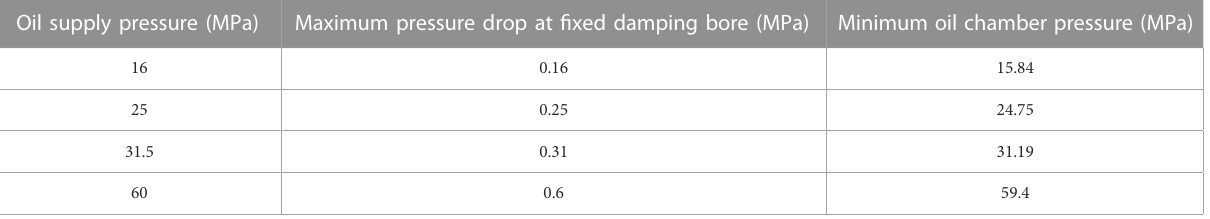
TABLE 2 Fitting